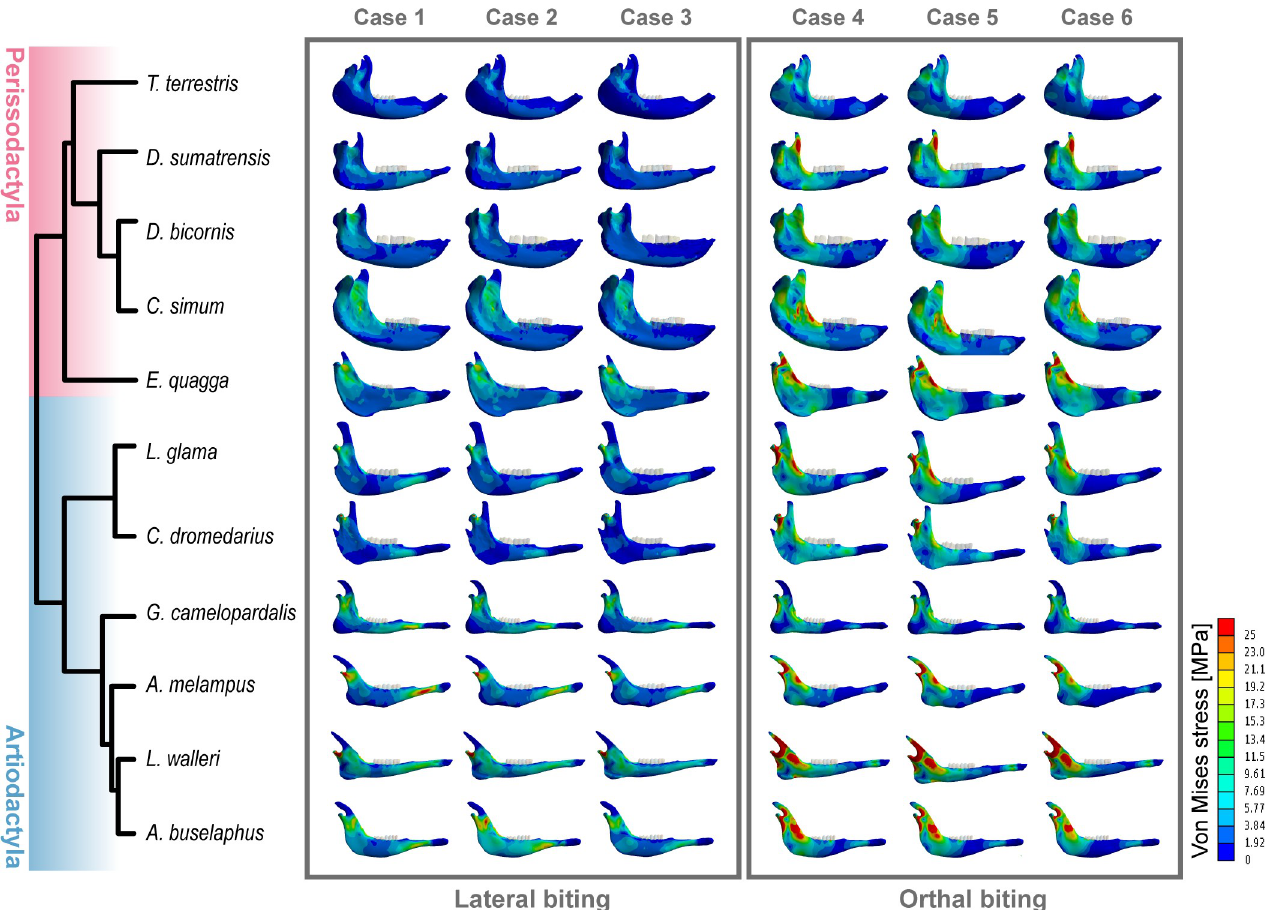
Fig 2. Phylogenetic tree and modelled von mises stress distribution in the mandible and the molars for each taxon for each bite configuration and bite position. Lateral cases 1) in M1 2) in M2 and 3) in M3. Orthal cases 4) in M1 5). In M2 and 6) in M3. Phylogenetic tree from http://10ktrees.nunn-lab.org/.